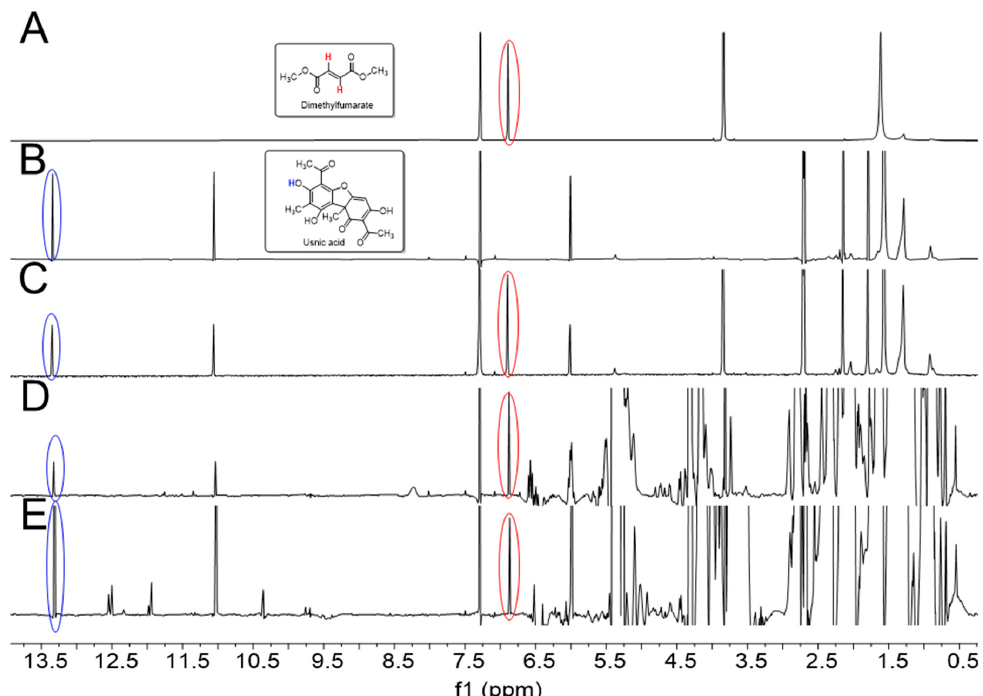
Figure 2. ( A ) 1 H-NMR spectrum of dimethyl fumarate (DMFum). The singlet signal (6.89 ppm) of the alkene moiety is indicated by the red circle; ( B ) 1 H-NMR spectrum of usnic acid (UA). The well separated singlet signal of the OH proton at C-8 (13.33 ppm) is indicated by the blue circle; ( C ) 1 H-NMR spectrum of a 1:1 molar mixture (DMFum/UA), showing the expected integral ratio of the